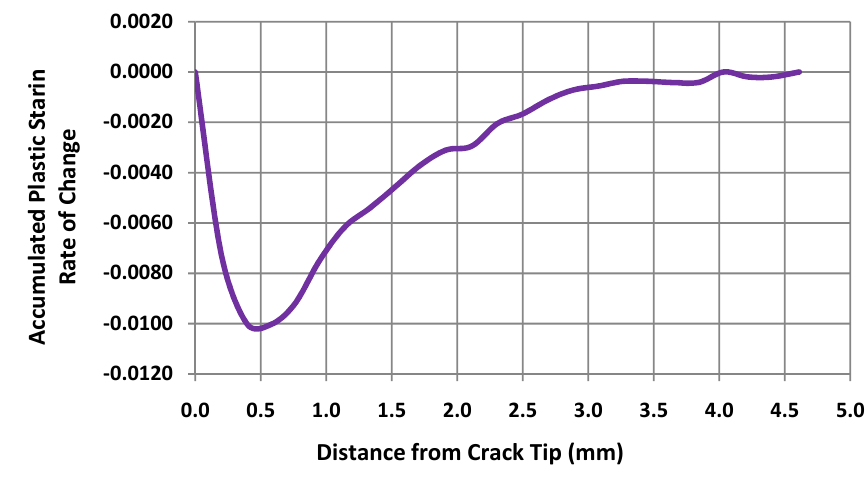
Figure 2. Estimated average accumulated plastic strain rate of